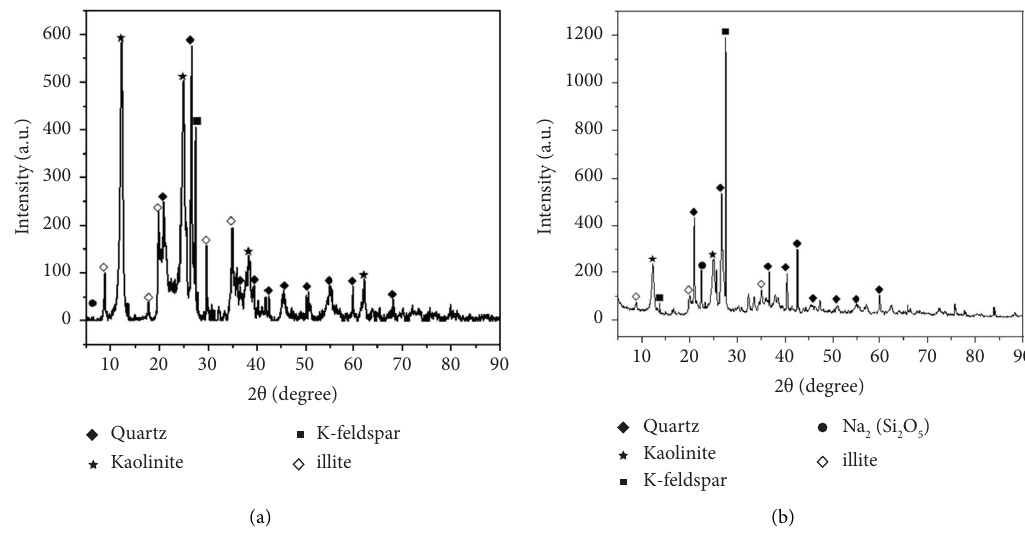
Figure 11: XRD patterns of GRS (a) and LC-0.5-G